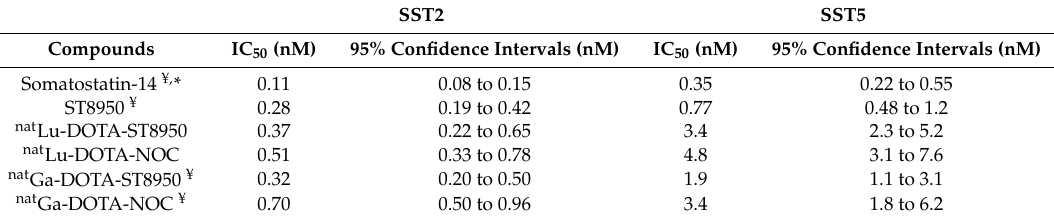
Table 2. Binding a ffi nities of the nat Lu-DOTA-conjugates for somatostatin receptor subtype 2 (SST2) and SST5, compared to reference compounds. SST2 SST5 Compounds IC 50 (nM) 95% Confidence Intervals (nM) IC 50 (nM) 95% Confidence Intervals (nM) Somatostatin-14 ¥, * 0.11 0.08 to